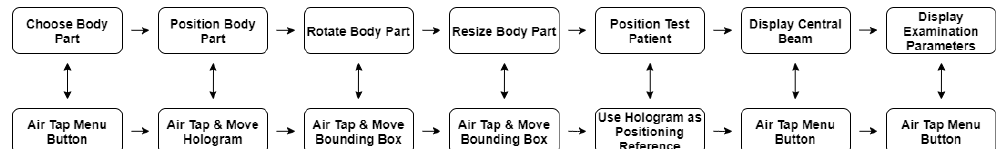
Figure 4. Subdivided user tasks with their corresponding user interactions. (1) Choose a body part; (2) position the body part on the training surface; (3) rotate the body part; (4) resize the hologram; (5) position the test patient; (6) display the central beam; (7) display additional parameters.